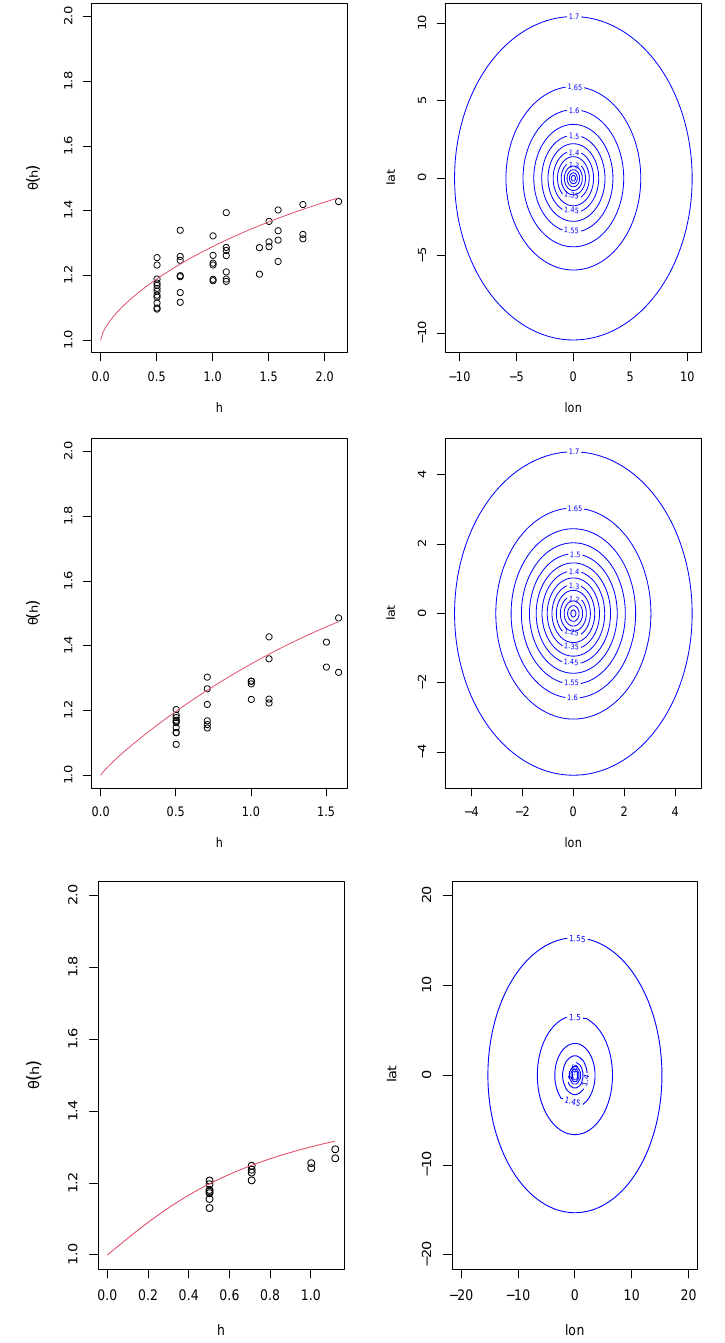
Figure 9. ( Top panel ) Cluster 1, ( Middle panel ), cluster 2 and ( Bottom panel ) Cluster 3 plots of (i) first column extremal coefficient θ ( h ) against distance h for the average annual precipitation and (ii) second column extremal coefficient changes as longitudes and latitudes